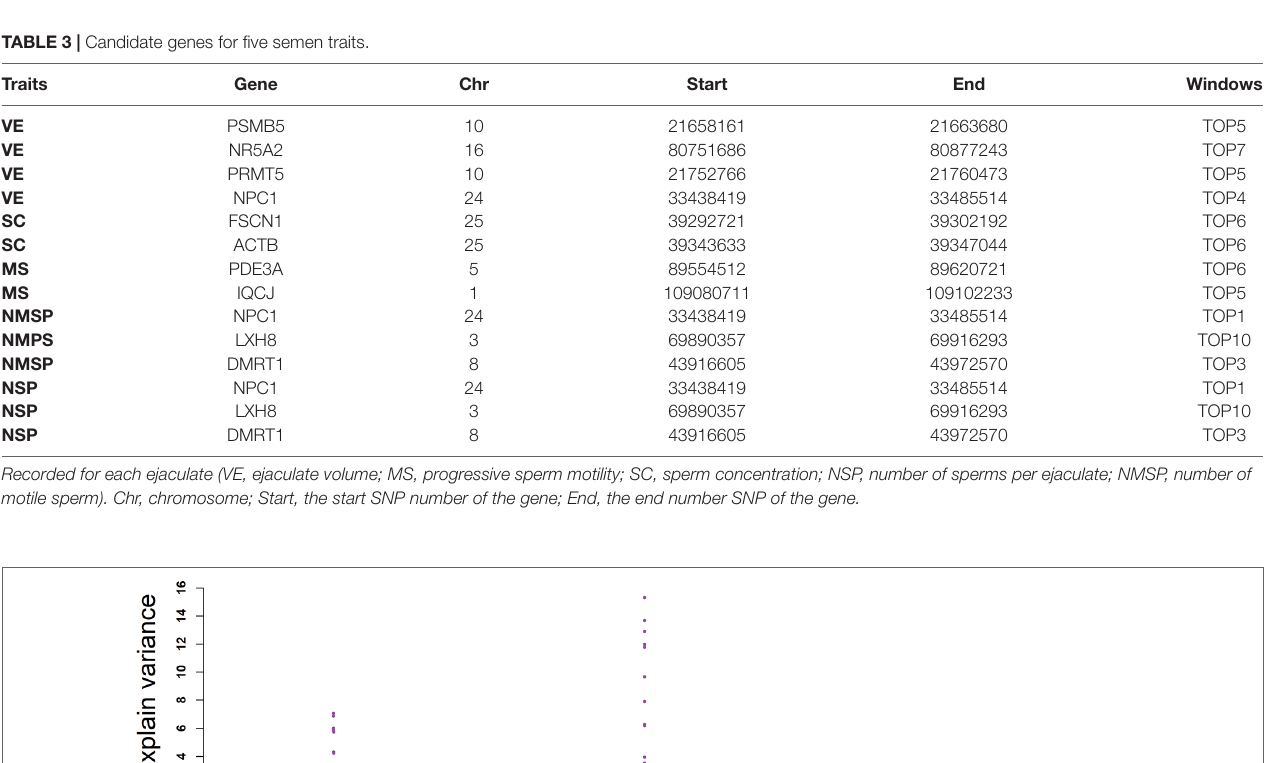
Frontiers in Genetics |